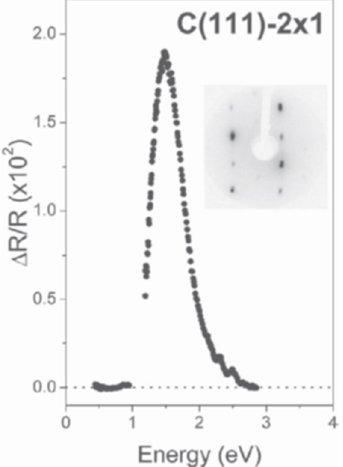
Figure 1. ∆ R/R as a function of photon energy for a single domain C(111)-2 × 1 surface, in the energy range from 0.4 to 2.8 eV. The sharp peak (whose sign means light electric field along the 1D chains of the reconstructed surface) is related to optical transitions between the surface electronic bands. The inset shows a low-energy electron diffraction (LEED) picture taken at 70 eV, demonstrating the existence on the reconstructed surface of a largely dominating single domain. Doubling of the spots is due to the regular array of surface steps. More extended experimental details are reported in Ref. [27]. Reproduced from G. Bussetti et al., Europhys. Lett. 2007, 79, 57002, with permission.